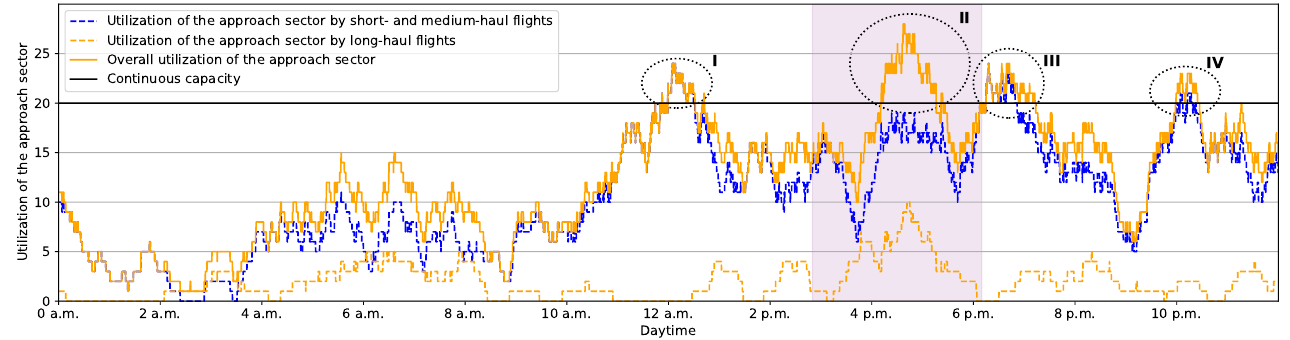
Figure 5. Approach sector utilization during the example day (5 April 2019), based on historic data. If the arrival time at the approach sector is modified by LR-ATFM activities, compared to the historic flights, the time spent within the approach sector may change as well due to different traffic conditions within the approach sector. Therefore, an assumption for the time aircraft spent in the approach sector for LR-ATFM regulated flights is specified based on the time distribution of the historic flight data, which is shown in Figure 6. The most frequent observed flight time within the approach sector is around 35 min. Higher flight times are possible for holdings or inefficient arrival routes, which leads to a right skew of Figure 6. The box plot underlines the statement since the time difference between the 25% quantile and lower whisker is three times lower compared to the time difference between the upper whisker and 75% quantile. Since the example day represents a busy weekday, we decided to assume a flight time within the approach sector similar to the 75% quantile (40:25 min) for regulated long-haul